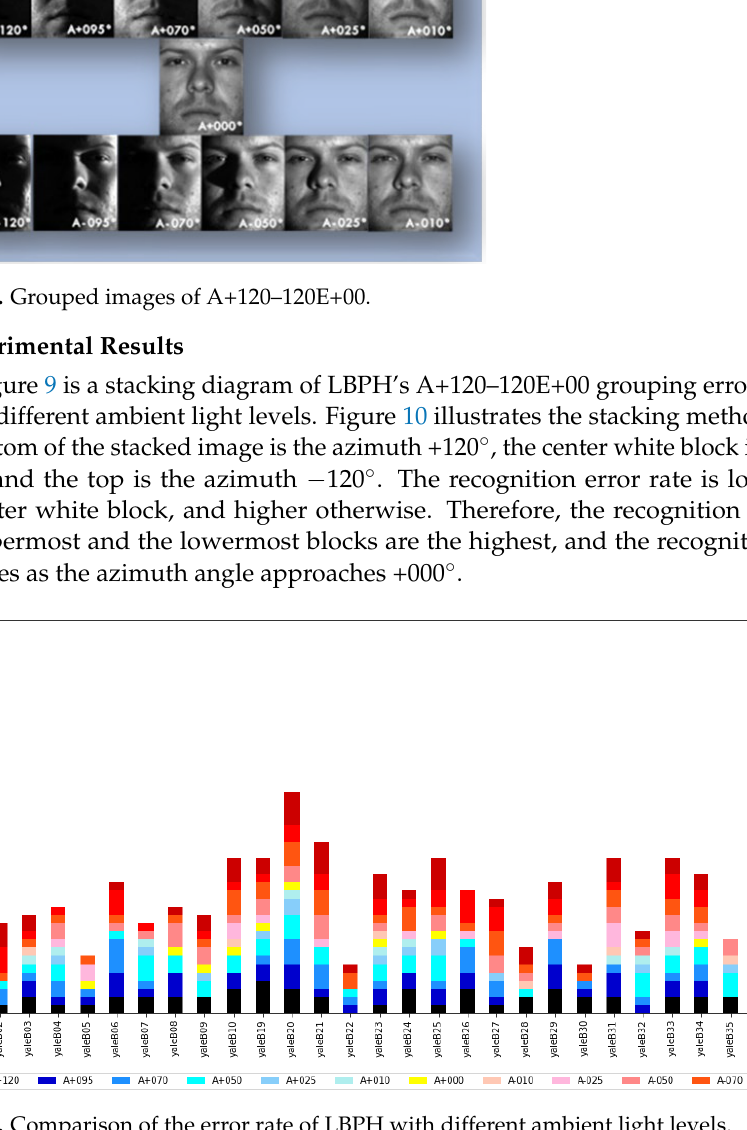
Figure 10. Illustration of stacked graphs of different illumination error rates for a single user. Figure 11 is a stacking diagram of OpenFace’s A+120--120E+00 grouping error rate comparison of different ambient light levels. The recognition error rates of the uppermost and the lowermost blocks are the highest, and they decrease as the azimuth angle ap- proaches +000°. Overall, OpenFace’s recognition error rate was about 20% to 49% higher than LBPH’s in A+120--120E+00 grouped images.